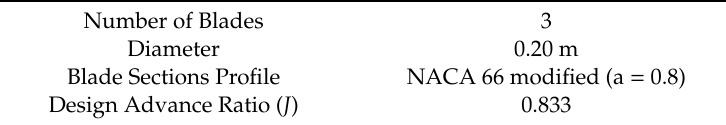
Figure 3. DTMB 4119 propeller. Table 1. Main Particulars of DTMB 4119 Propeller [20].